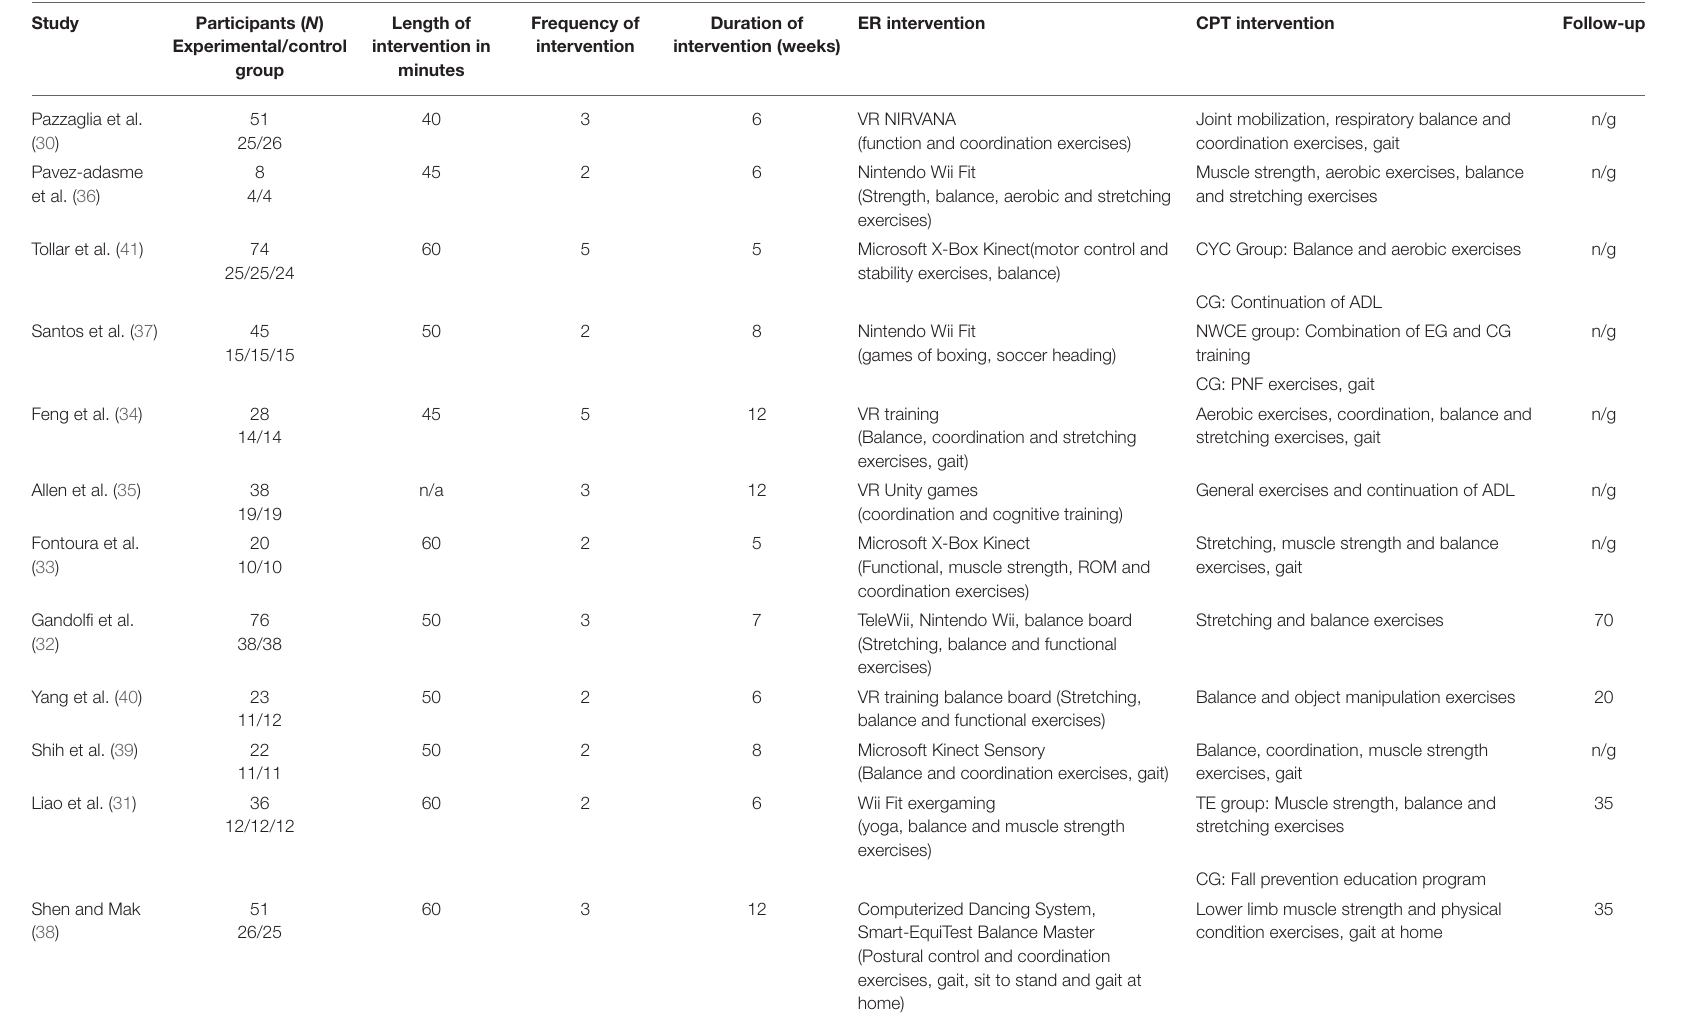
TABLE 3 | Characteristics of the